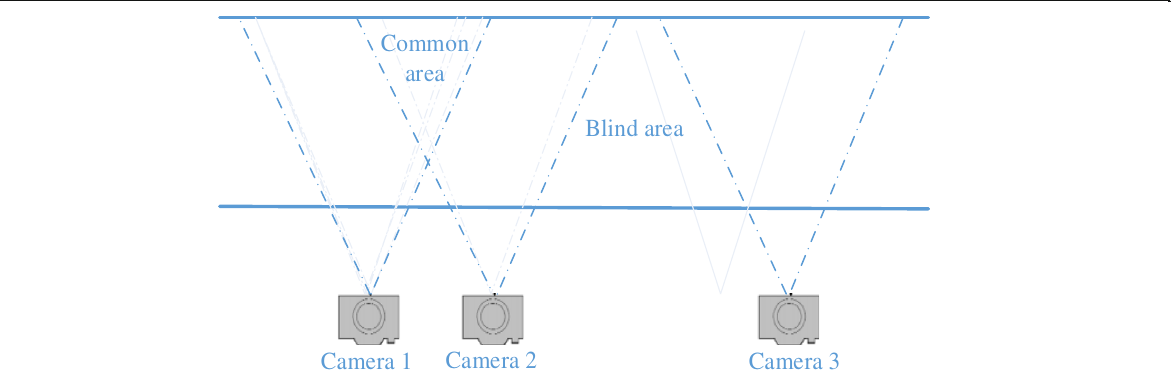
Fig. 1 An example for the topology of a camera